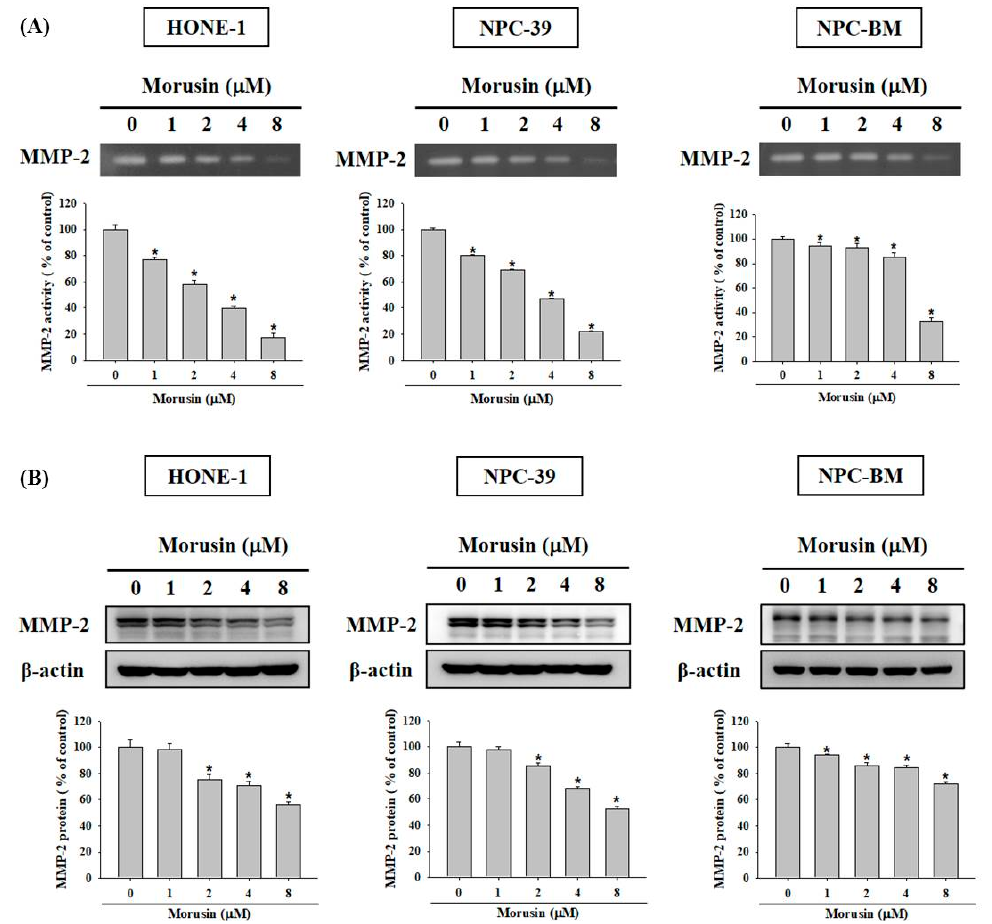
Figure 4. Morusin inhibits the activity and expression of MMP-2 in NPC cells. HONE-1, NPC-39, and NPC-BM cells were treated with morusin (0–8 µ M) for 24 h ( A ) Conditioned media were subjected to gelatin zymography for analyzing the activity of MMP-2. ( B ) Total cell lysates were prepared for determining the levels of MMP-2 protein. * p < 0.05, compared with the untreated control.